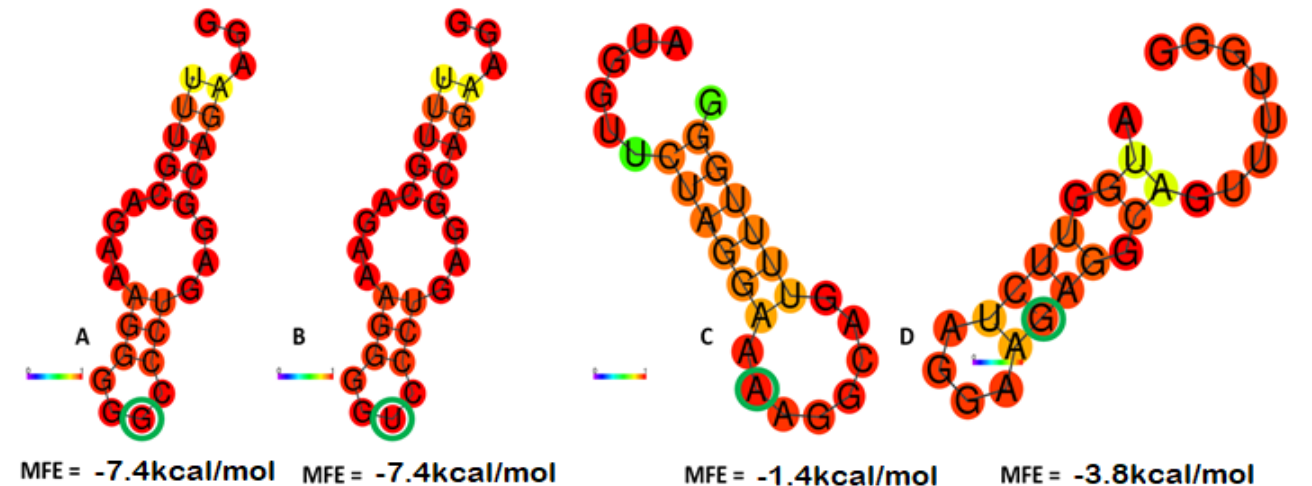
Figure 1. MFE value of mRNA secondary structures: ( A ) rs923331350 wild-type G allele; ( B ) rs923331350 variant U allele; ( C ) rs1331232028 wild-type A allele; ( D ) rs1331232028 variant G allele . Wild-type and altered alleles are highlighted with green circle.